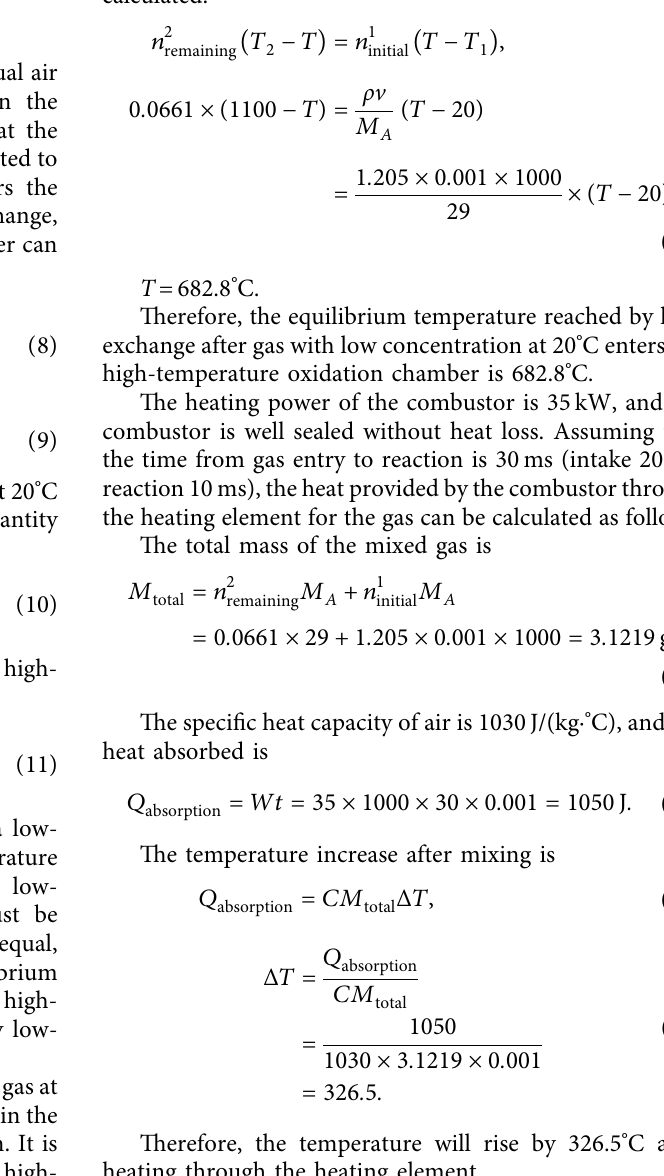
Figure 4: Calculus